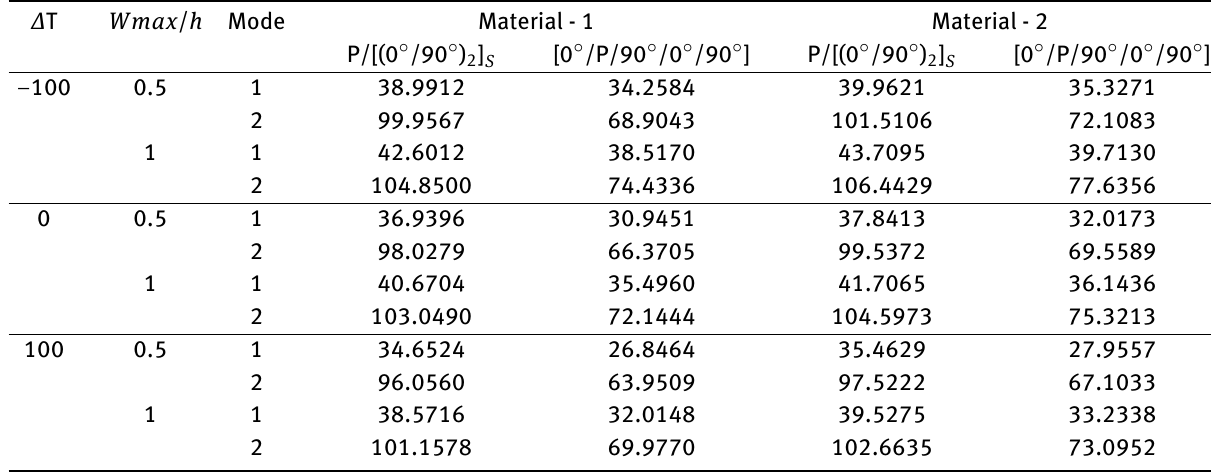
Table 12: Effect of thermal loading, amplitude ratio, frequency mode, material properties and lamination scheme on dimensionless mean nonlinear natural frequency of conical shell panel with LC / h = 100